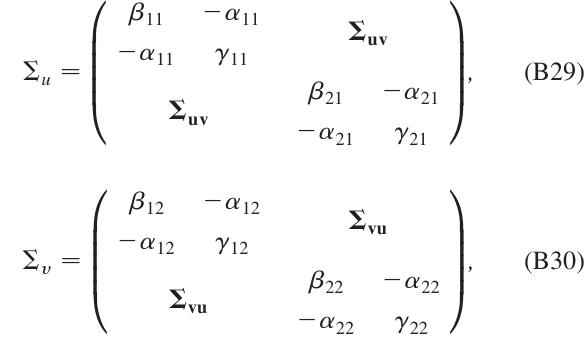
products with the 4 (cid:8) 4 matrix ~ U , synchrobetatron cou- pling not being included here. Only the four diagonal elements of A are of interest for the damping integrals.